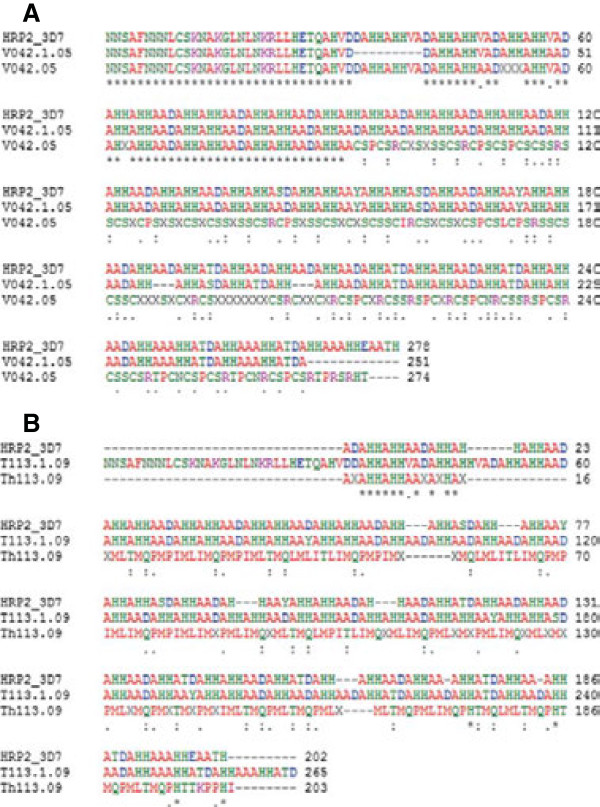
PCR re-sequencing. To confirm the frameshifting polymorphisms in isolates SenTh113.09 and SenV042.05, PCR amplification and re-sequencing of the region surrounding the polymorphic positions corresponding to aa571 and aa574 in the coding sequence were performed. A: Alignment of the re-sequenced SenV042.1.05 PfHRP2 sequences with 3D7 isolate. The two sequences share 91.1% identity. B: Alignment of the re-sequenced SenTh113.1.09 PfHRP2 sequence with 3D7 isolate showed 79.7% identity. These results suggest that errors in Illumina sequencing or GATK’s Unified Genotyper produced a false call in these two cases.